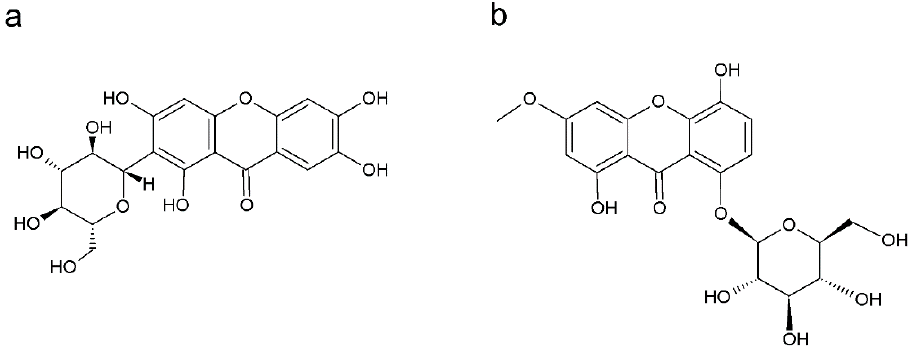
Figure 3. Structure of mangiferin, C-glycoside ( a ) and swertianolin, O-glycoside ( b